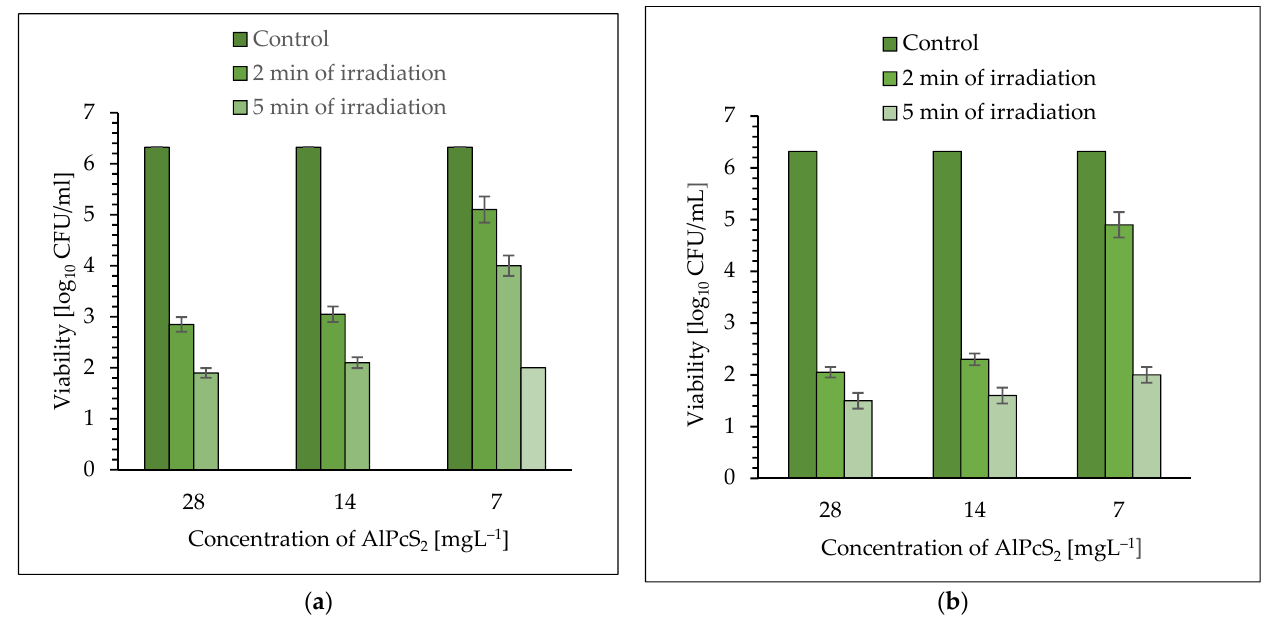
Figure 3. The effect of AlPcS 2 on viability of S. aureus after exposure to laser light for 2, 5, and 10 min. ( a ) laser light ( λ = 650 nm; the radiation power density of 105 mW cm − 2 ); ( b ) laser light ( λ = 650 nm; the radiation power density of 210 mW cm − 2 ). Average SD of three independent experiments is shown. The efficiency of this treatment was considered as statistically significant for all groups ( p <